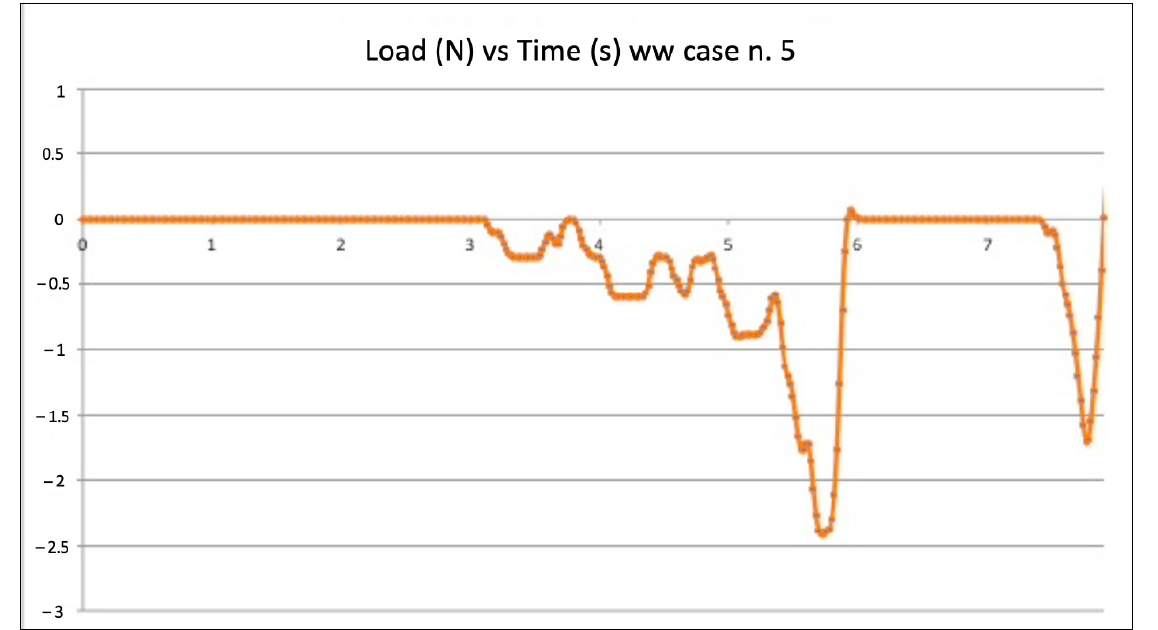
Figure 4. Graphic plot of the simulation on model n. 5 (successful watch winding motion negotiation).